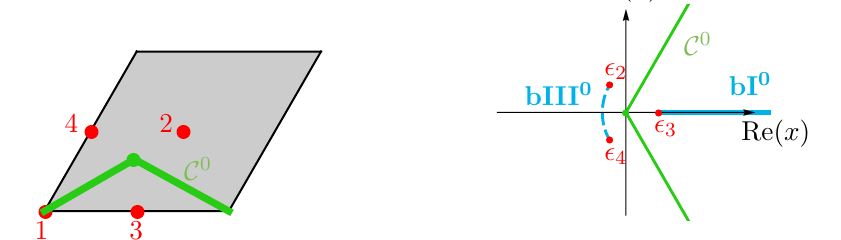
Figure 7 . Graphical representation of the union cycle C 0 = bII + [ bII (cid:0) on a hexagonal torus lattice (left) and on an elliptic curve embedded in P 112 (right). The cycle C 0 is drawn in the x -plane ( v = 1) by virtue of Weierstrass’ elliptic